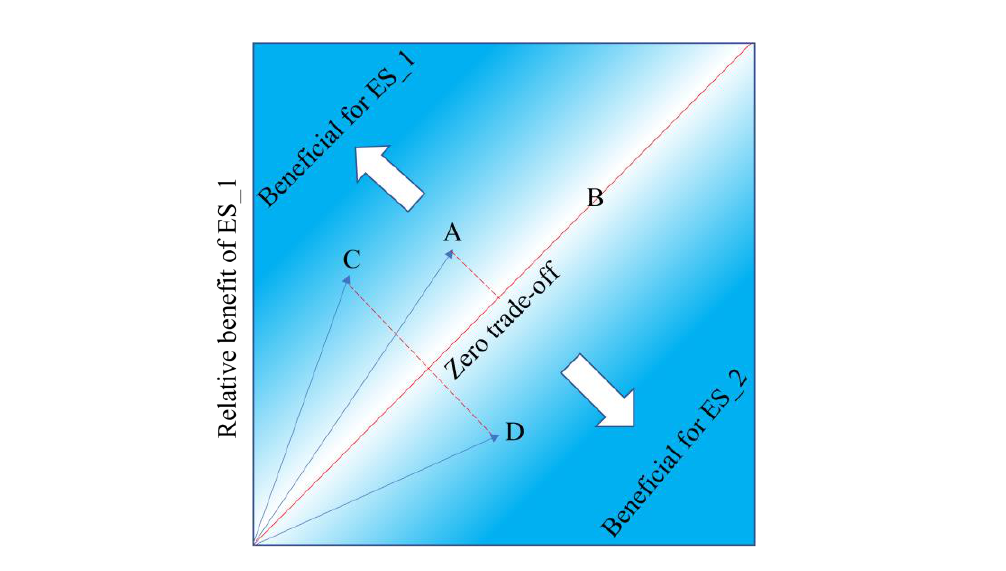
Figure 2. Trade-off between the two ESs is expressed through the root mean square deviation.